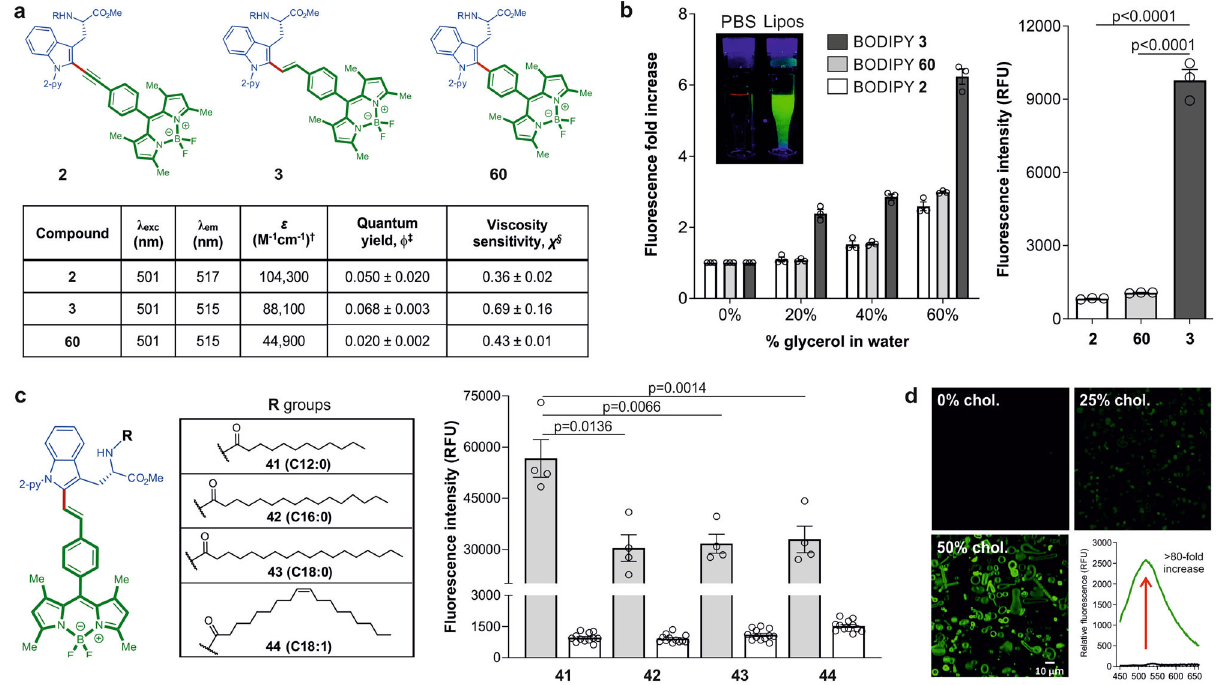
Fig. 5 Evaluation of fl uidity-sensitive fl uorogenic BODIPY probes. a Spectral properties of the BODIPY amino acids 2, 3 , and 60 . λ exc : 450 nm. [ † ] Measured in EtOH, [ ‡ ] measured in glycerol:H 2 O (6:4) with fl uorescein in basic EtOH as a standard, [ § ] measured in glycerol:H 2 O mixtures with increasing viscosity. b Fluorescence bar plots displaying the fl uorescence fold increase in 0 – 60% glycerol in water (left) and fl uorescence emission in 60% glycerol- water (right) of amino acids 2, 3 , and 60 (25 µ M), λ exc : 450 nm. Inset) Pictograms of compound 3 under UV excitation in PBS (left) and in liposome suspensions (right). c Fluorescence emission bar plot of lipid- fl uorophore conjugates 41 – 44 (1 µ M) after incubation in phosphatidylcholine (PC): cholesterol liposome suspensions (gray) and in PBS (white), λ exc : 450 nm. d Fluorescence confocal microscopy images of compound 41 (1 µ M, green) after incubation with DMPC-based liposomes containing increasing amounts of cholesterol. Scale bar: 10 µ m. In all panels, data presented as means ± SEM from experiments performed at least in triplicate. Fluorescence spectra of compound 41 (1 µ M) in cholesterol-containing liposomes (green) and in PBS (black). Data presented as means± SEM ( n = 4) for emission in presence of liposomes and ( n = 12) for emission in PBS. P values obtained from ONE-ANOVA tests with multiple comparisons. ε , molar extinction coef fi cient; lipos., liposomes; chol.,